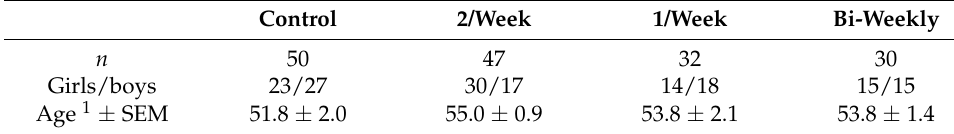
Table 2. Subjects’